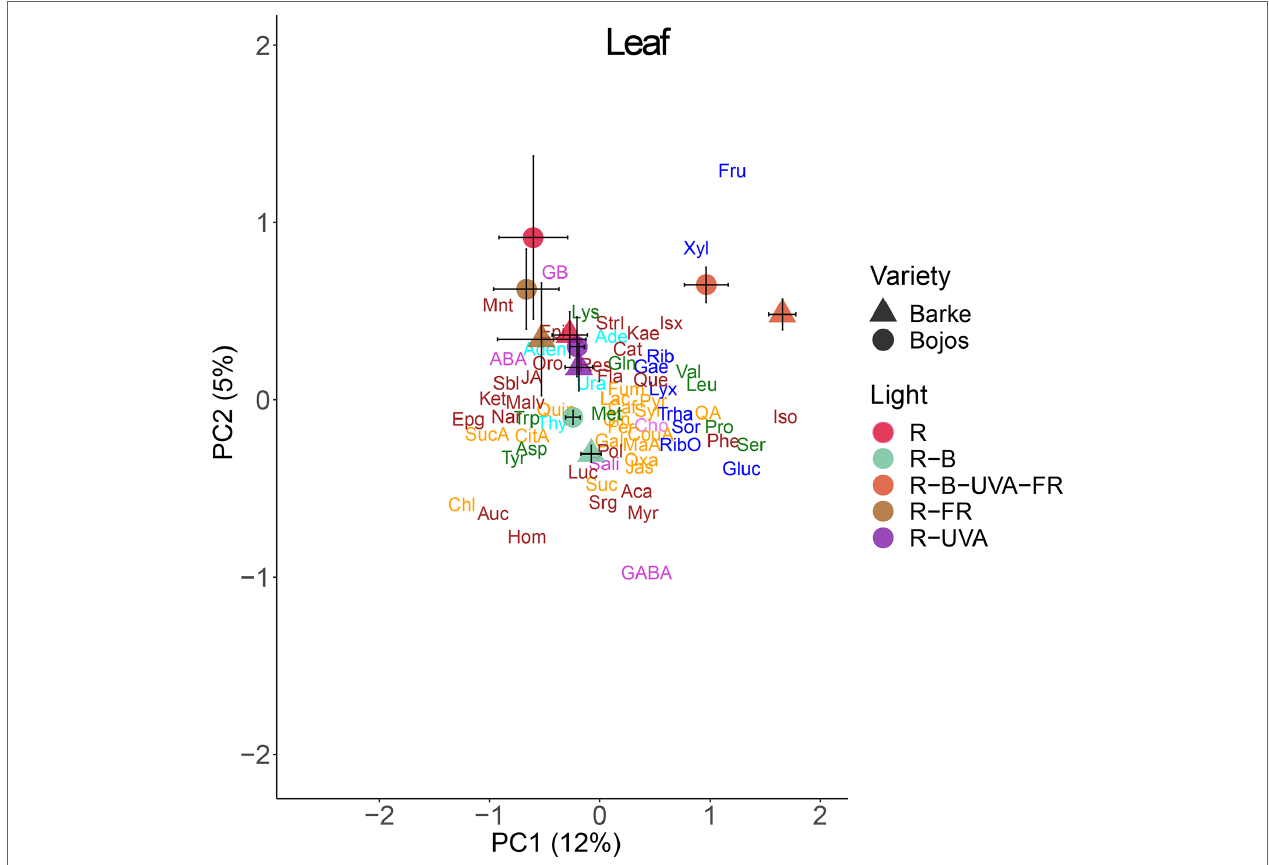
FIGURE 6 | Principal component analysis (PC1 vs. PC2) of leaf metabolite concentrations of two barley varieties grown for 26 days under different light regimens. Here and in Figures 8 and 9 : values for each variety (circles, Bojos; triangles, Barke) and light regimen (red, R; R-B, cyan; R-B-UVA-FR, orange; R-FR, brown; R-UVA, purple) are presented as means and standard deviations (error bars). Loadings of PC1 and PC2 for individual metabolite concentrations are represented by abbreviations. The data from individual replicates ( n = 4) were used for the analysis. Biochemical families are represented by colors: dark blue, sugars; green, amino acids; yellow, compounds involved in the metabolism of amino acids and sugars; cyan, nucleotides; brown, phenolics; and violet, others. Abbreviations of metabolites: uracil (Ura), adenine (Ade), thymidine (Thy), adenosine (Aden), D-ribose (Rib), D-lyxose (Lyx), D-xylose (Xyl), D-fructose (Fru), 5-methylthio-D- ribose (RibO), D-sorbose (Sor), D-glucose (Gluc), D-galactose (Gae), D-(+)-trehalose dehydrate (Trha), lysine (Lys), glutamine (Gln), leucine (Leu), isoleucine (Iso), phenylalanine (Phe), methionine (Met), tryptophan (Trp), valine (Val), acid aspartic (Asp), tyrosine (Tyr), proline (Pro), serine (Ser), succinic acid (SucA), citrate acid (CitA), malic acid (Mal), lactic acid (Lac), quinic acid (Qui), pyruvate (Pyr), p -coumaric acid (CouA), jasmone (Jas), gallic acid (Gal), maleic acid (MaA), fumarate (Fum), trans-caffeic acid (Caf), aconitate (Suc), quinic acid (QA), trans-ferulic acid (Fer), syringic acid (Syr), oxaloglutarate (Oxa), jasmonic acid (JA), cinnamic acid (Cin), chlorogenic acid (Chl), γ -aminobutyric acid (GABA), glycine-betaine (GB), choline (Cho), sodium salicylate (Sali), (-)-abscisic acid (ABA), resveratrol (Res), acacetin (Aca), kaempferol (Kae), epicatechin (Epi), alpha-ketoglutaric acid (Ket), quercetin (Que), epigallocatechin (Epg), myricetin (Myr), aucubin (Auc), isovitexin (Isx), homoorientin (Hom), lucenin (Luc), malvidin (Malv), naringenin (Nar), flavan-3-ol (Fla), catechin (Cat), sorgolactone (Srg), (+)-orobanchol (Oro), (+)-strigol (Strl), polyols (Pol), mannitol (Mnt), sorbitol